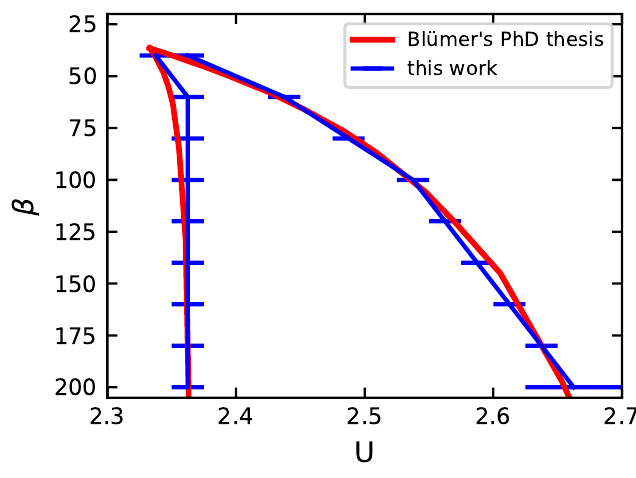
( T ) and U ( T ) obtained by us compared to the c 1 c 2